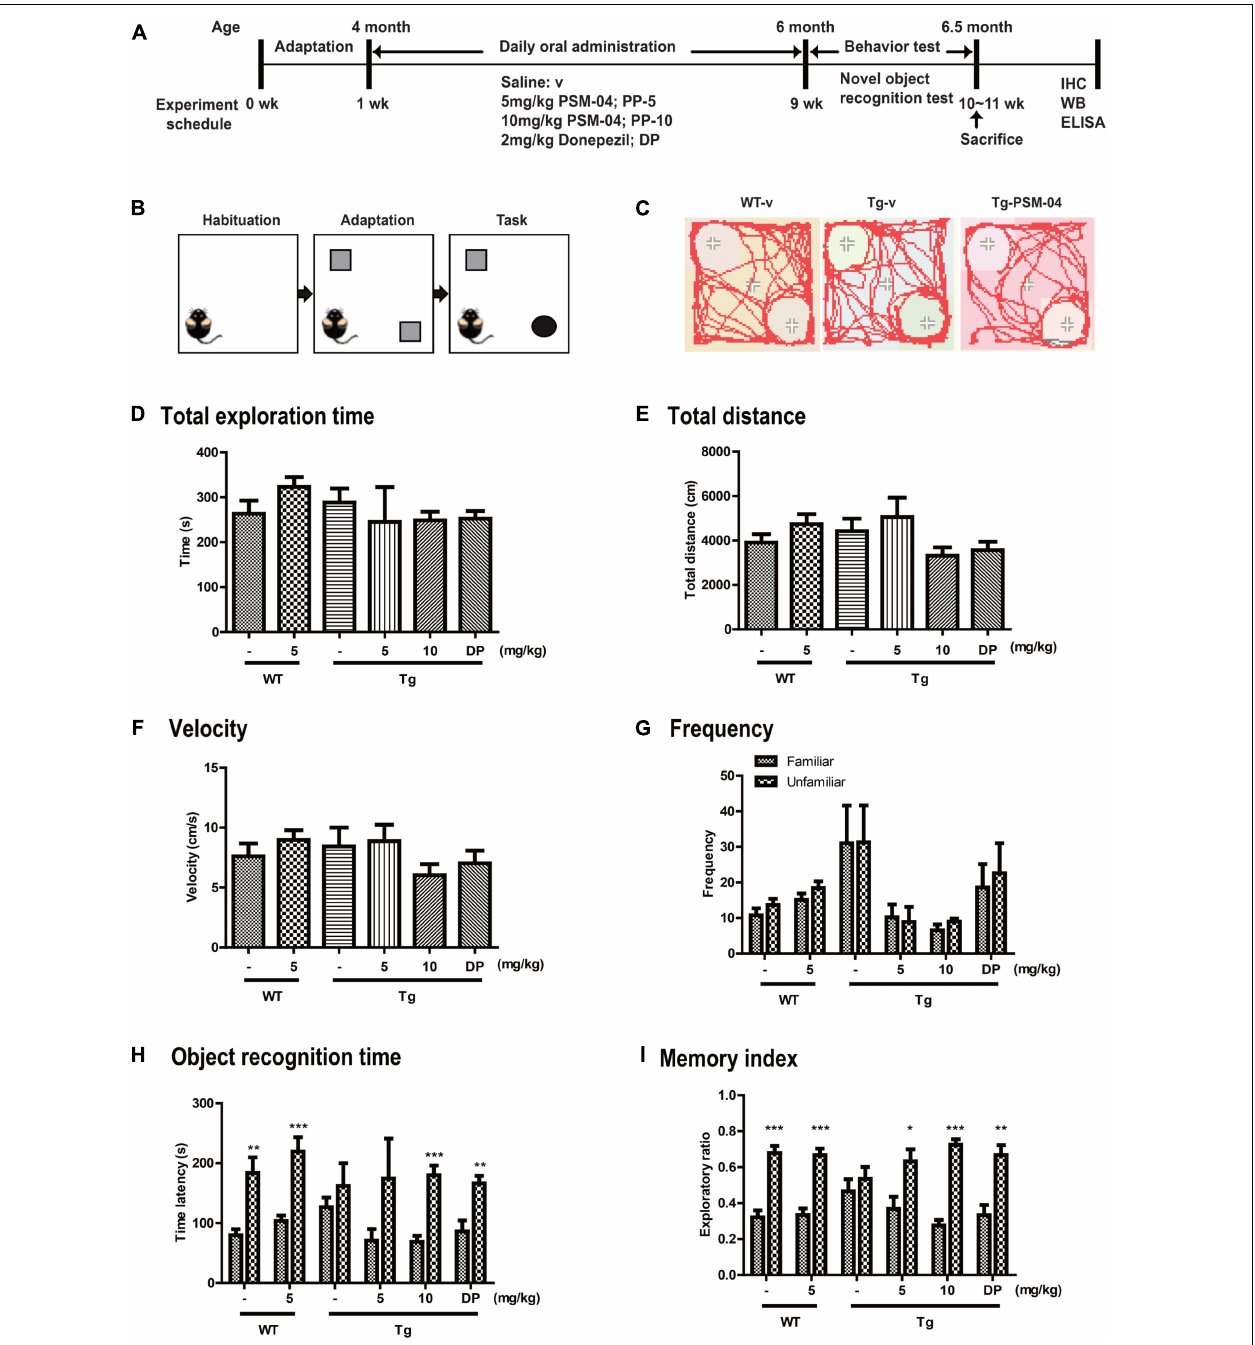
FIGURE 3 | PSM-04 alleviated cognitive impairment in 5xFAD mice. (A) A schematic diagram of the in vivo experimental plan is shown. (B) The design of a novel object recognition (NOR) task is shown; in the habituation phase (30 min duration), mice were adapted to the open-field box. In the adaptation phase, the mice were exposed to two same objects. On the last day, one object was changed to a novel object and recorded for 10 min. (C) Representative track sheets showed alteration in locomotion and exploratory behavior in the NOR task (distance traveled to familiar vs. unfamiliar object). (D–I) Graphs represent total exploration time (D) , total distances (E) , velocity (F) , frequency (G) , objective recognition time (H) , and the memory index (I) . The statistical analyses were performed by one-way ANOVA, and data are presented as means ± SEM. ∗ p < 0.05, ∗∗ p < 0.01, and ∗∗∗ p < 0.001. Vehicle-treated WT mice (WT-v, n = 8); 5-mg/kg PSM-04-treated WT mice (WT-PP-5, n = 10); vehicle-treated Tg mice (Tg-v, n = 7); 5-mg/kg PSM-04-treated Tg mice (Tg-PP-5, n = 6); 10-mg/kg PSM-04-treated Tg mice (Tg-PP-10, n = 6); donepezil-treated Tg mice (Tg-DP, n = 5).